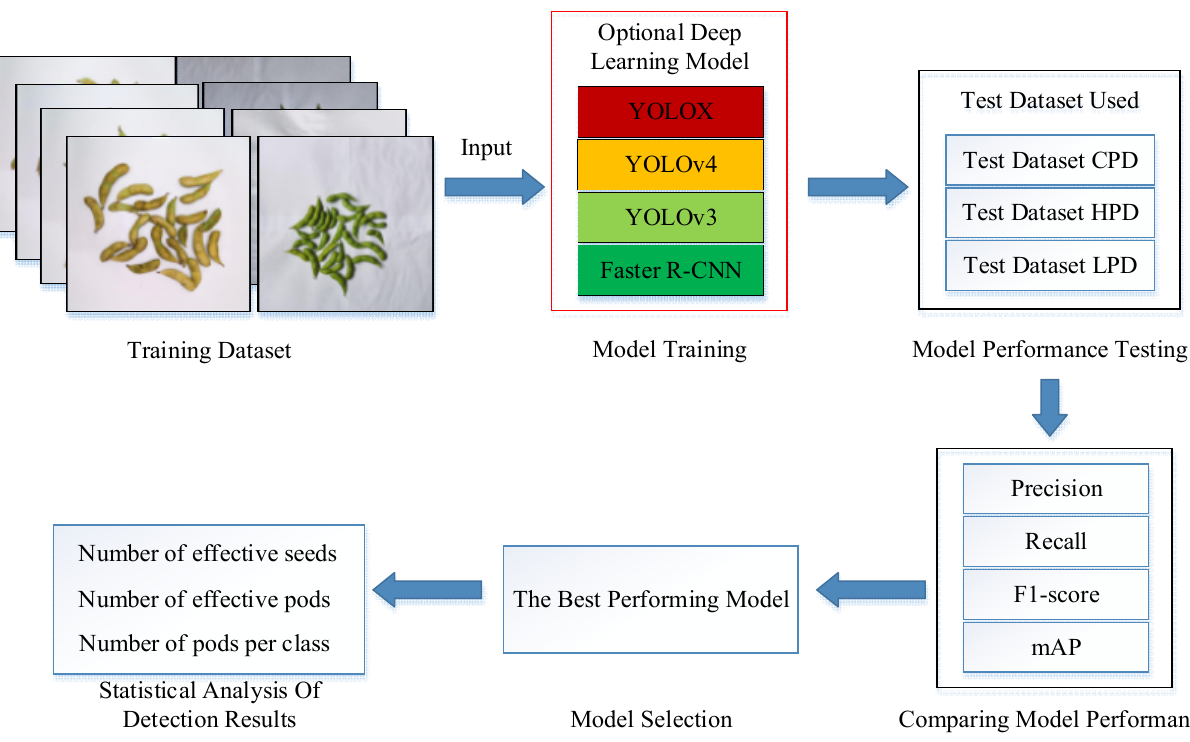
Figure 5. The key flow of pod classification and counting model construction.